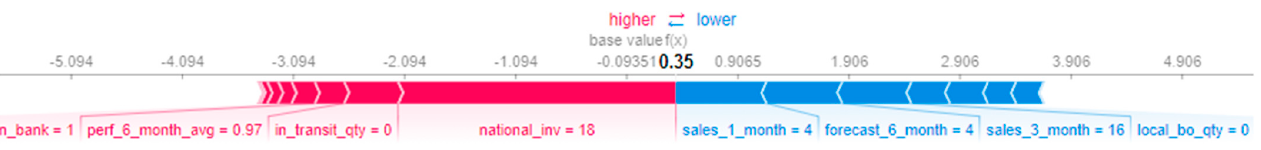
Figure 8. Product correctly classified as non-backordered.